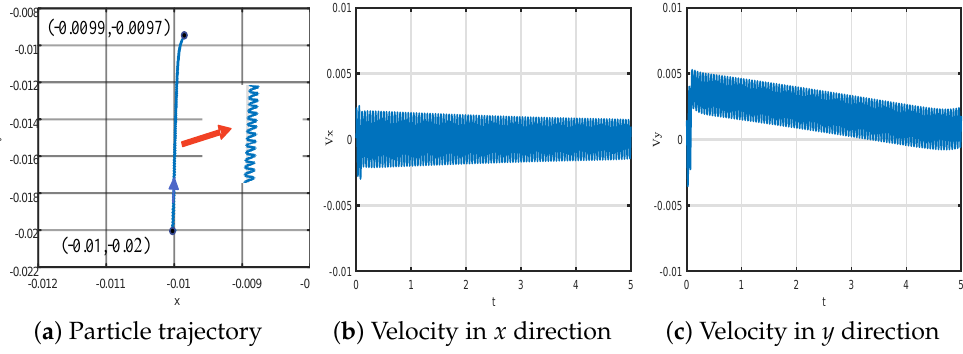
Figure 6. Particle trajectory simulation in sliding region of the third